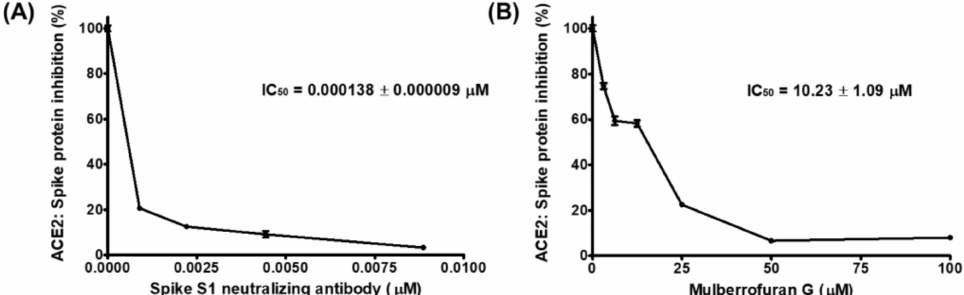
Figure 1. Inhibitory effect of mulberrofuran G (MG) on the binding of spike protein S1 receptor- binding domain (RBD) to the human angiotensin-converting enzyme 2 (ACE2) receptor. Spike protein coated on a 96-well plate interacted with a preincubated mixture of the ACE2 receptor and ( A ) antibody to the spike protein as the positive control and ( B ) 0, 3.125, 6.25, 12.5, 25, 50, or 100 µ M MG. The inhibition of the binding of the spike S1 RBD to the ACE2 receptor by MG was evaluated by measuring